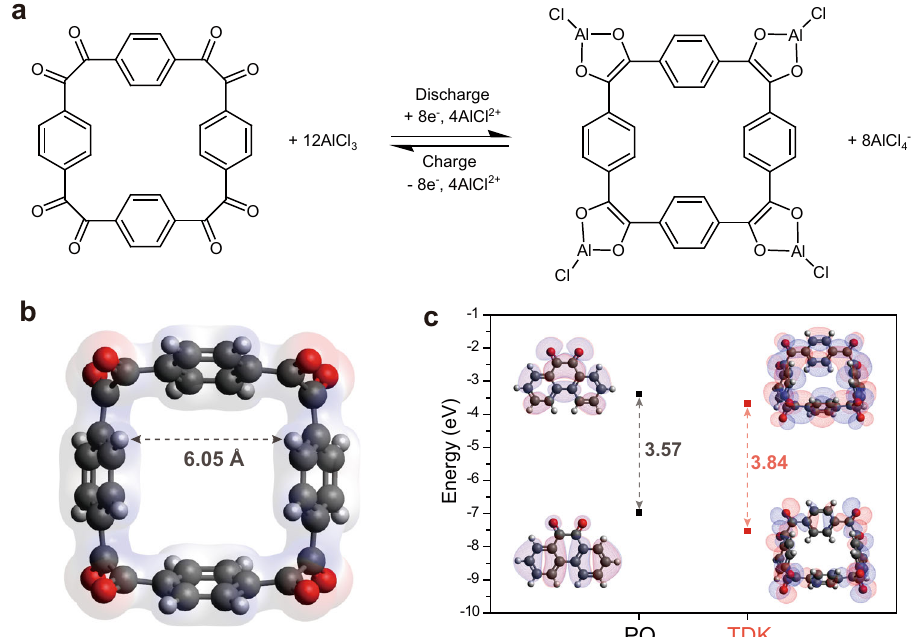
Fig. 1 Design and properties of the tetradiketone (TDK) macrocycle. a Illustration of electrochemical redox mechanism of TDK. b Optimised structure and electron density of TDK in its pristine state. c HOMO-LUMO energy levels of the optimised structures of phenanthrenequinone (PQ) and